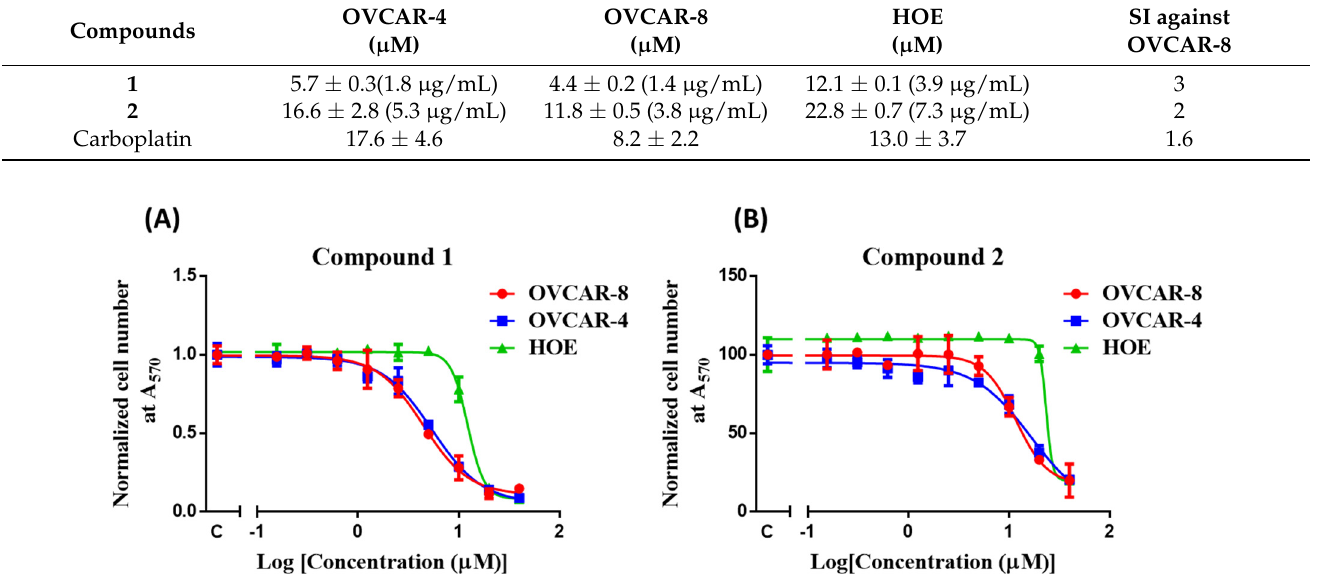
Figure 2. Mean concentration-response curve of compound 1 ( A ) and 2 ( B ) in OVCAR-4 and OVCAR-8 ovarian cancer cells and HOE. IC 50 values determined are listed in Table 1. Table 1. The growth inhibitory activities of isolated compounds ( 1 and 2 ) from J. insularis in OVCAR-4, OVCAR-8 cancer cell lines and HOE cells. The selectivity index (SI) (the ratio of IC 50 against HOE cells to IC 50 against OVCAR-8) are indicated.